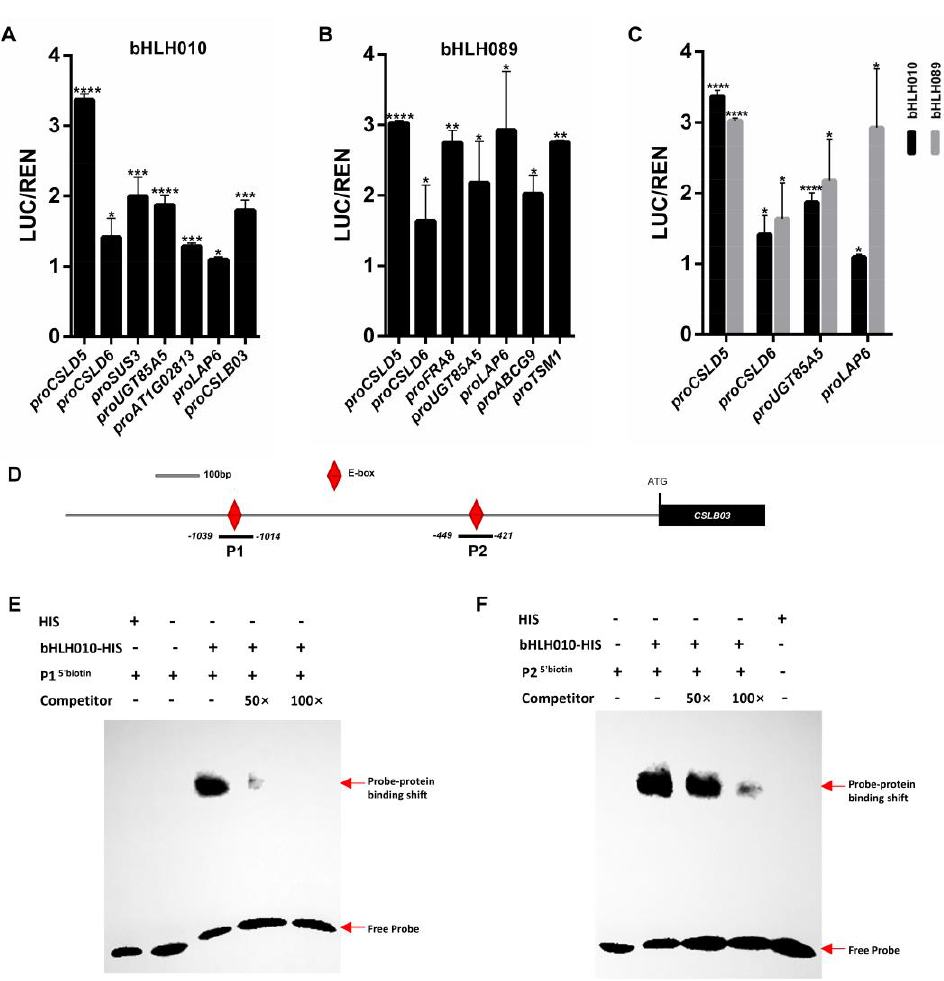
Figure 6. bHLH010 activates the expression of CSLB03 and directly binds to the two E-boxes at the CSLB03 promoter. ( A – C ) Dual-luciferase assay was used to detect the transcriptional activation activity of bHLH010 and bHLH089 to downstream candidates. ( A ) The transcriptional activation activity of bHLH010 to downstream candidates. ( B ) The transcriptional activation activity of bHLH089 to downstream candidates. ( C ) The four genes that could be activated by both bHLH010 and bHLH089 are shown. Significant differences compared with WT were determined using Student’s t -test, which was used for difference comparison. *, p < 0.05; **, p < 0.01; ***, p < 0.001; ****, p < 0.0001. Data were means ± SD ( n = 3). ( D ) The CSLB03 promoter region (grey) has two predicted E-boxes (red rhombus). ( E , F ) EMSA of the binding of bHLH010 TF to the P1 ( E ) and P2 ( F ) E-box in the CSLB03 promoter region. The binding bands and the free probes are indicated with red arrows.